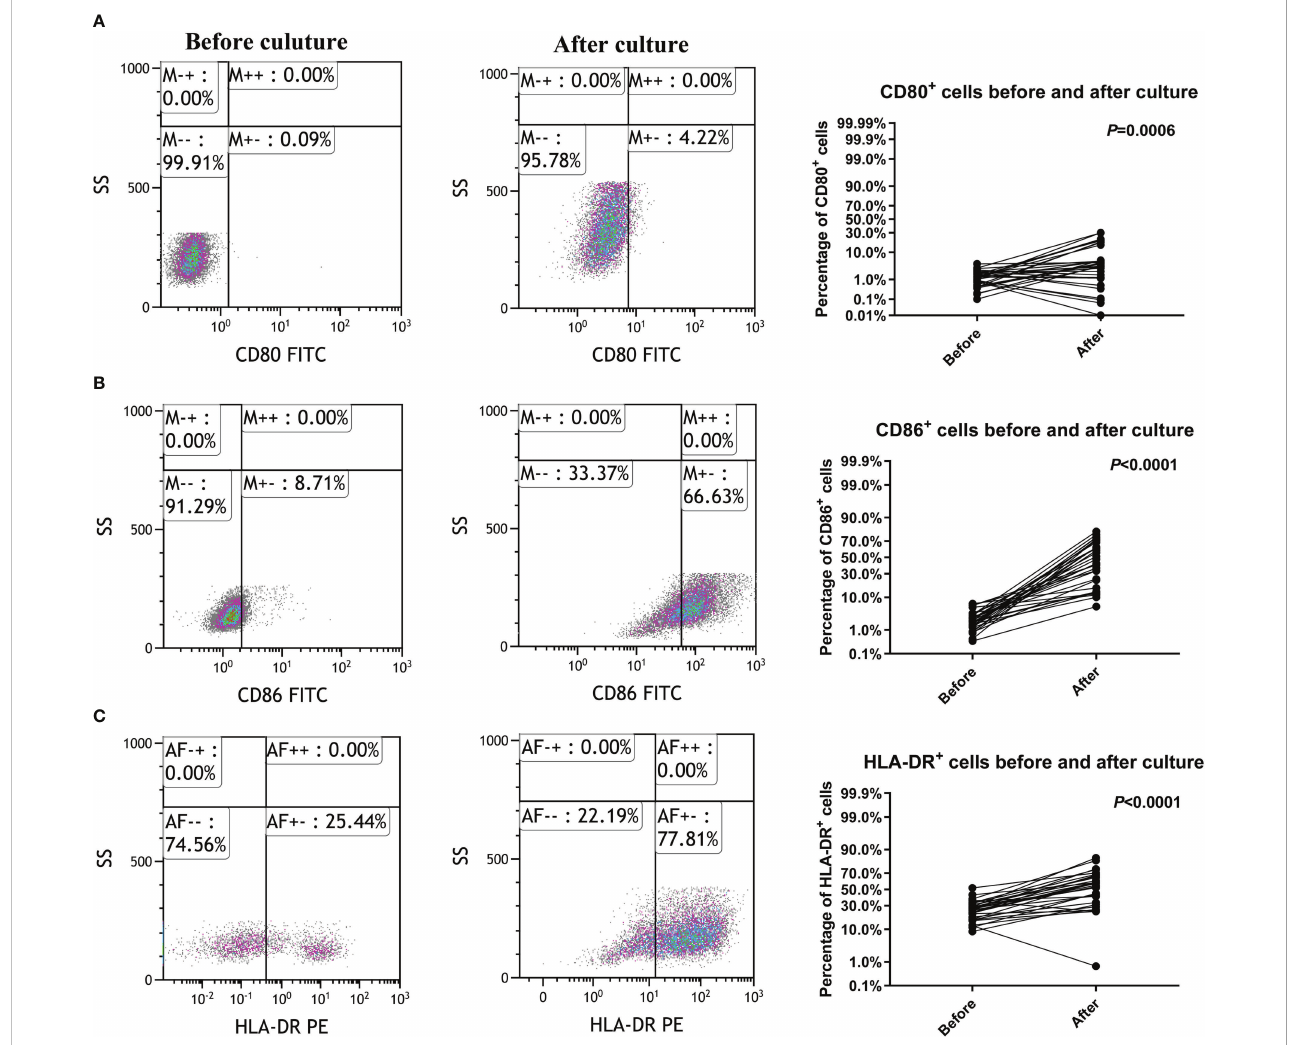
FIGURE 1 Cytotoxic T lymphocyte activation by culture and induction. (A) CD80 was upregulated in Cytotoxic T lymphocytes (CTLs). (B) CD86 was upregulated in CTLs. (C) HLA-DR was upregulated in